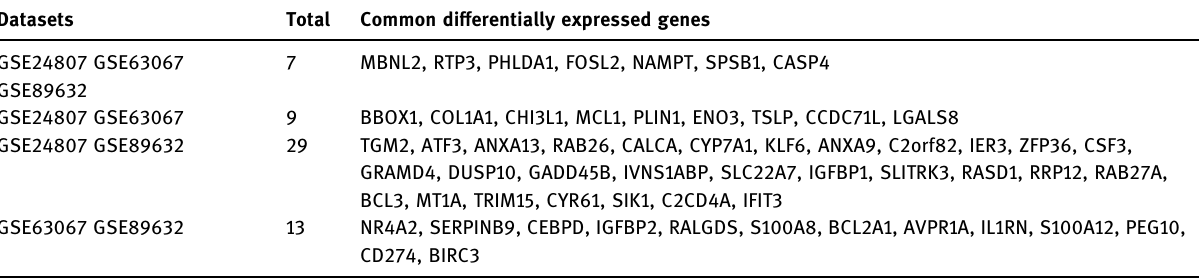
Table A3: Common di ff erentially expressed genes in the datasets Datasets